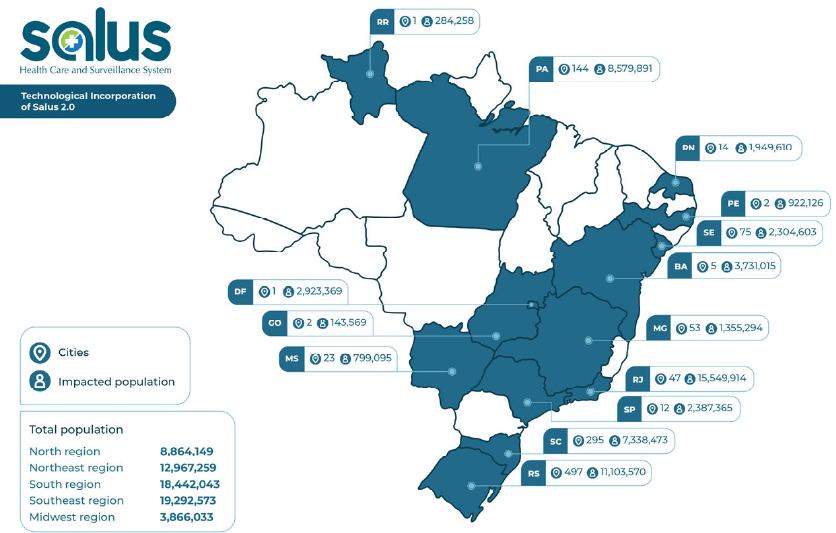
Figure 2. Implementation map of the Salus Platform in the Brazilian states. Source: elaboration of the authors.